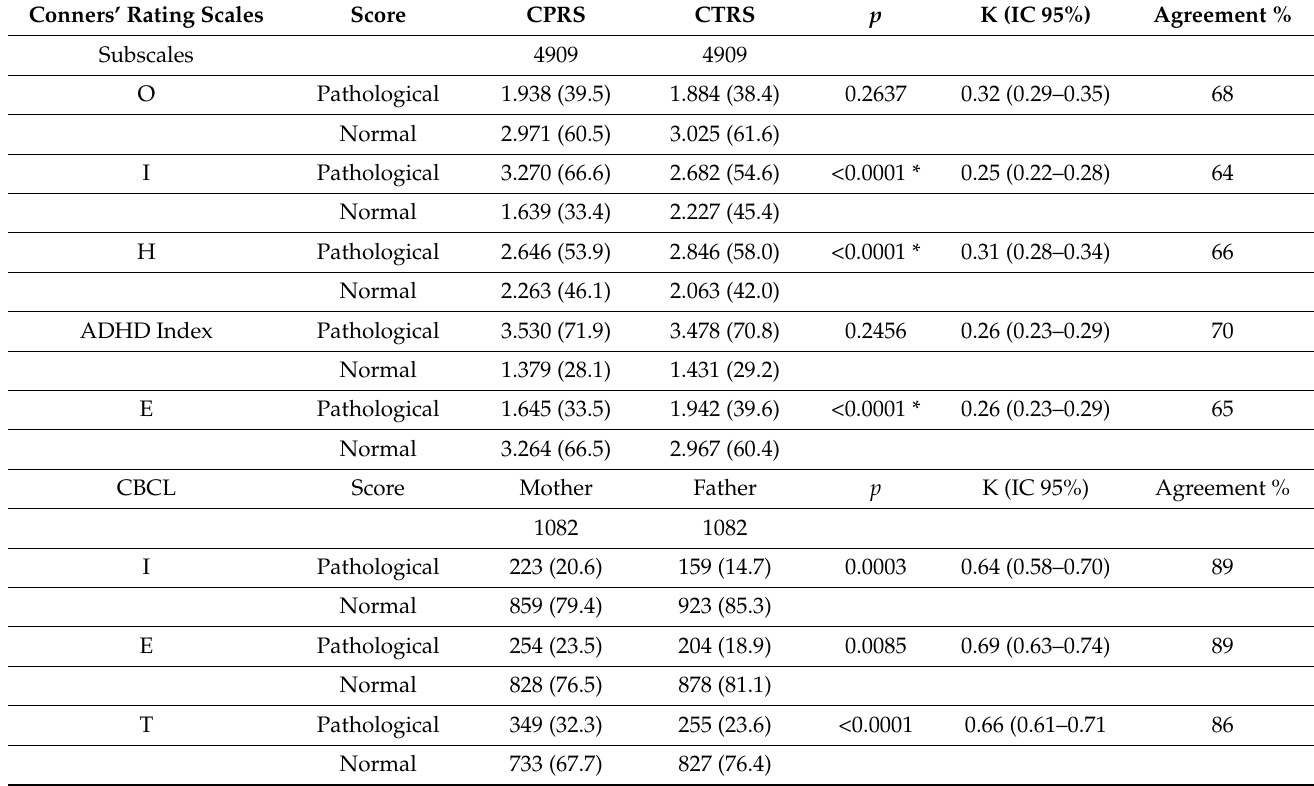
Table 3. Symptom severity perceptions by parents and